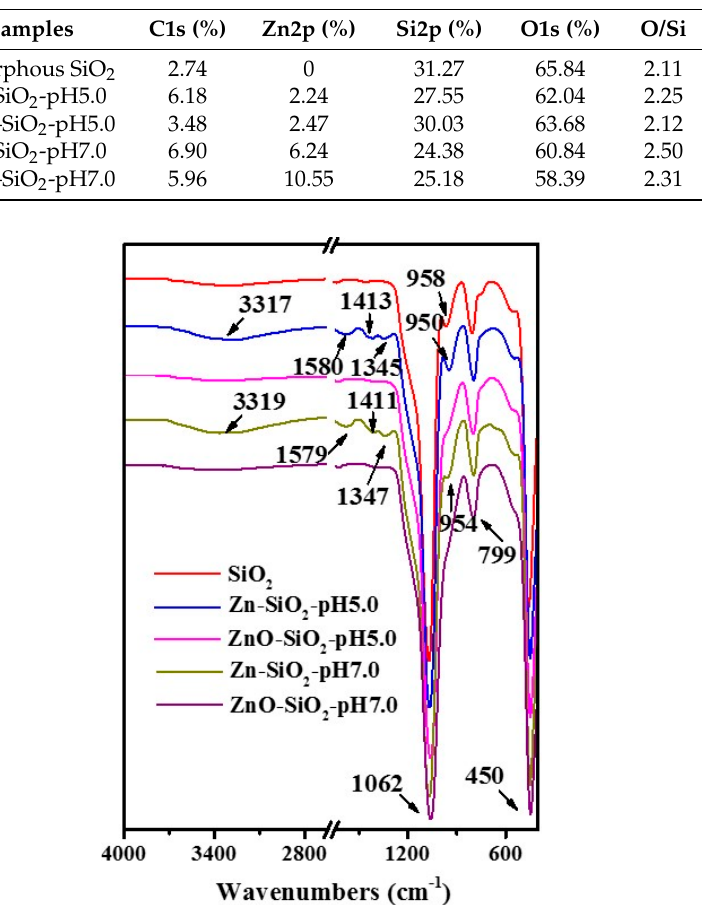
Figure 7. FTIR spectra of amorphous SiO 2 , Zn–SiO 2 -pH5.0, ZnO–SiO 2 -pH5.0, Zn–SiO 2 -pH7.0, and ZnO–SiO 2 -pH7.0.